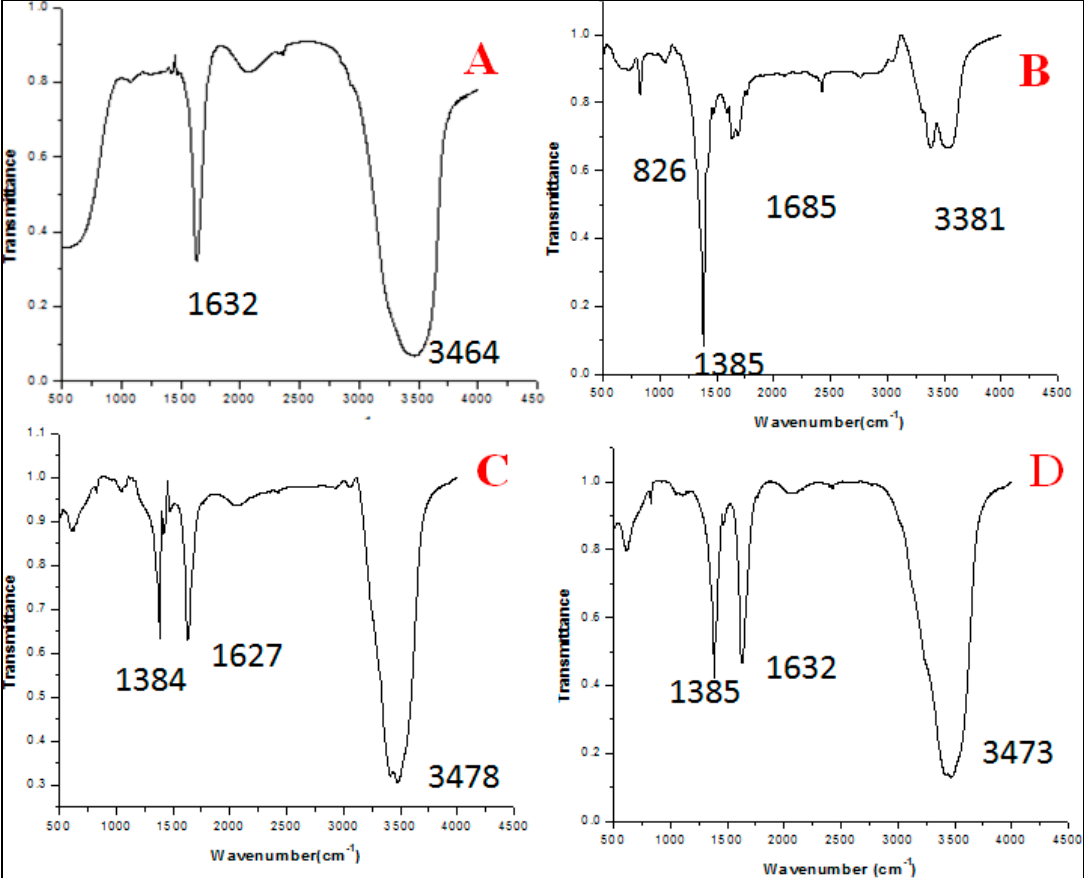
Figure 2. FTIR analysis between 4500–500 cm − 1 showing different peaks which are representative of different bonds formed during the synthesis of zinc nanoparticles at different concentration of extract. ( A ) 10 mL extract, ( B ) 20 mL extract, ( C ) 30 mL extract, and ( D ) 40 mL extract.